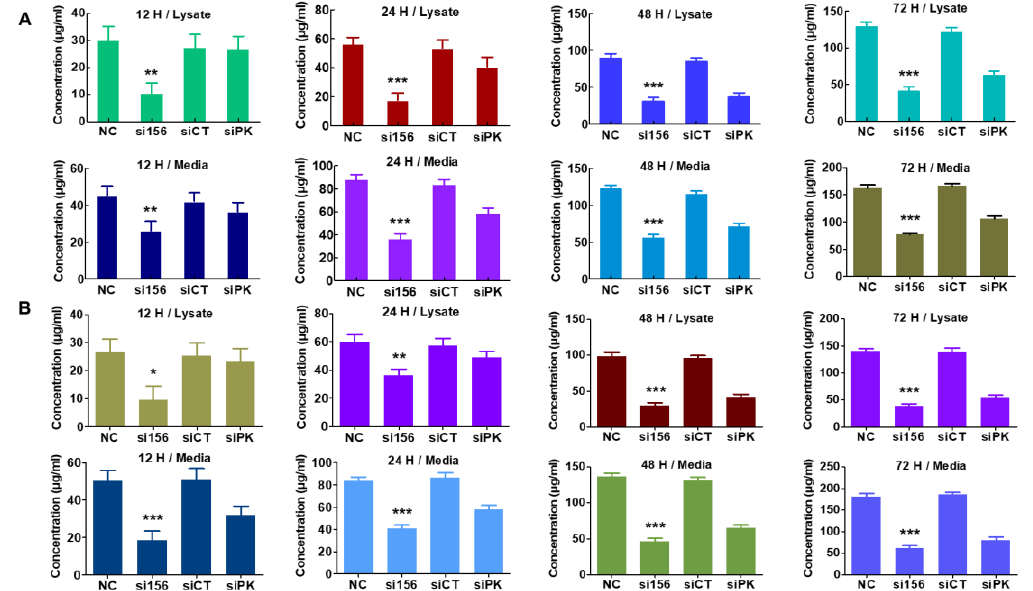
Figure 7. Effect of PKM2 expression knockdown on glycolytic metabolite levels in 786-O cells. ( A ) Quantitative level of pyruvate in lysates and media. PKM2 expression knockdown by si156 significantly reduced pyruvate level in lysates and media of PKM2 siRNA-transfected cells as compared with control cells after 72 h. ( B ) Quantitative level of lactate in lysates and media. si156 considerably reduced lactate level in lysates and media of 786-O cells as compared with control cells. One-way ANOVA was used to compare means of different groups. Differences between means were considered significant at p < 0.05 using Tukey’s multiple comparison test; * p < 0.05, ** p < 0.01, and *** p < 0.001 as compared with normal control cells.